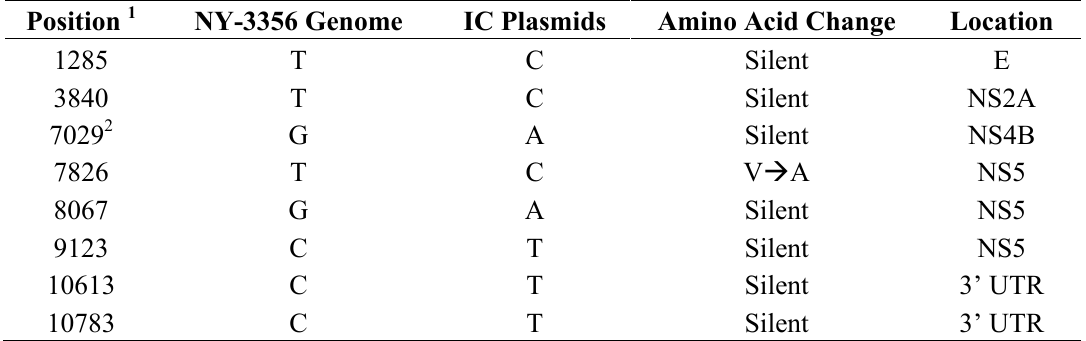
Table 1. Sequence differences between the infectious clone pA and pB plasmids and WNV strain